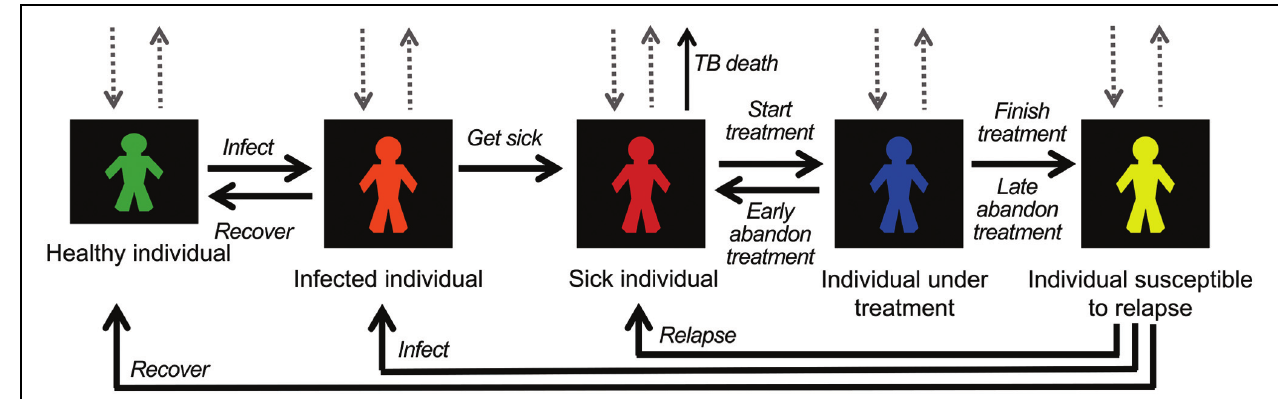
FIGURE 1 | State diagram of the model, where the five states of individuals and possible transitions are shown. Output gray dotted arrows refer to deaths; input dotted arrows are the corresponding entrances of randomly selected individuals in order to keep population